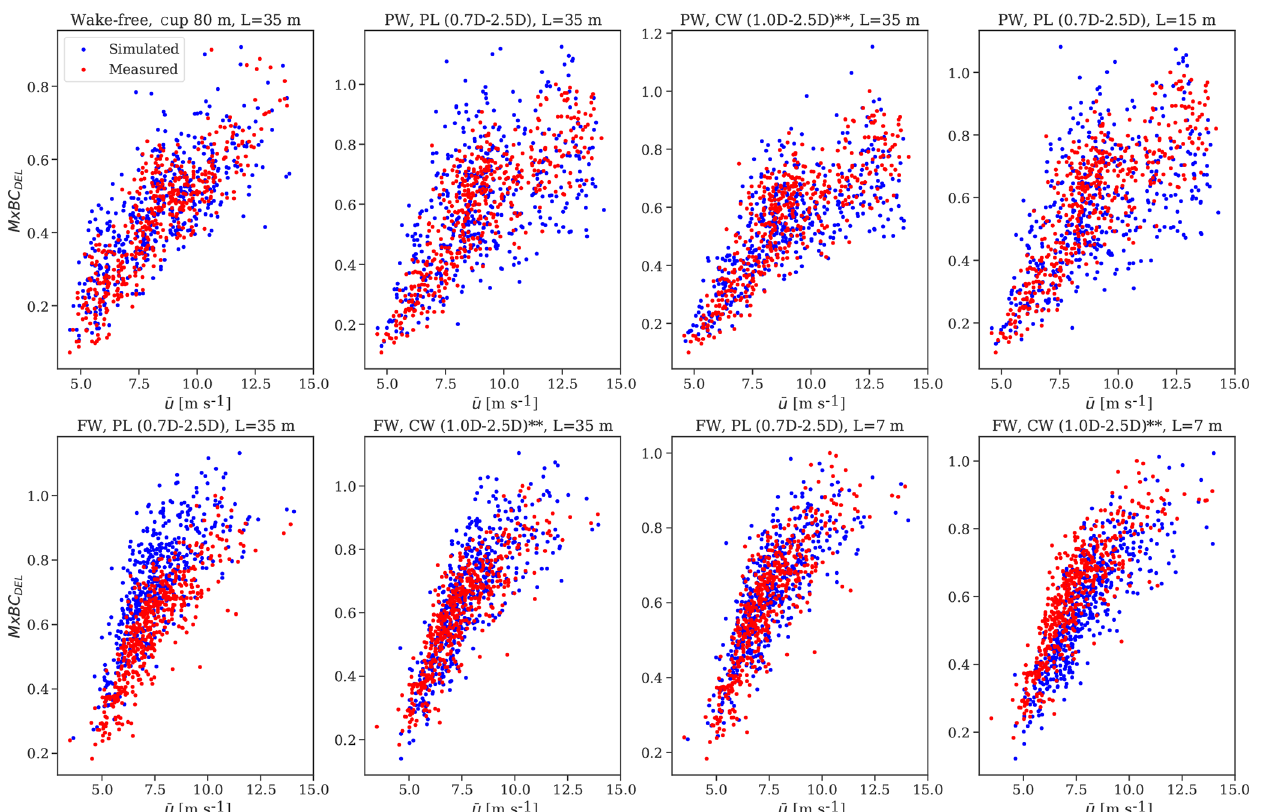
Figure C5. Scatter plots of the normalized measured and predicted fatigue flapwise bending moment at the blade-root realizations used in the